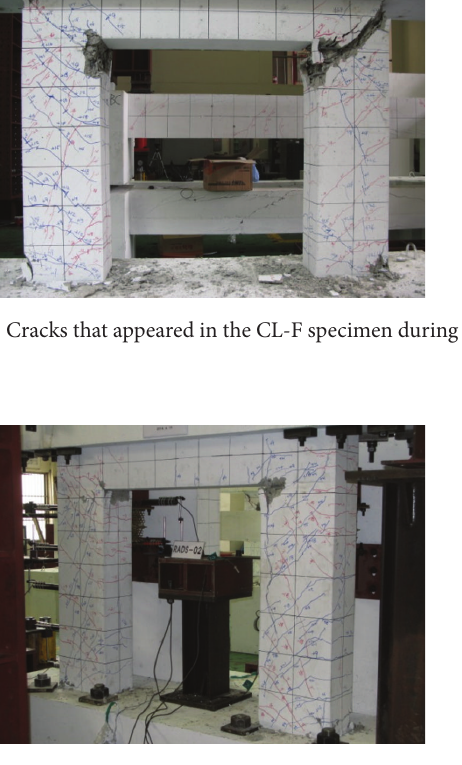
Figure 10: Cracks that appeared in the CL-FK specimen during cyclic